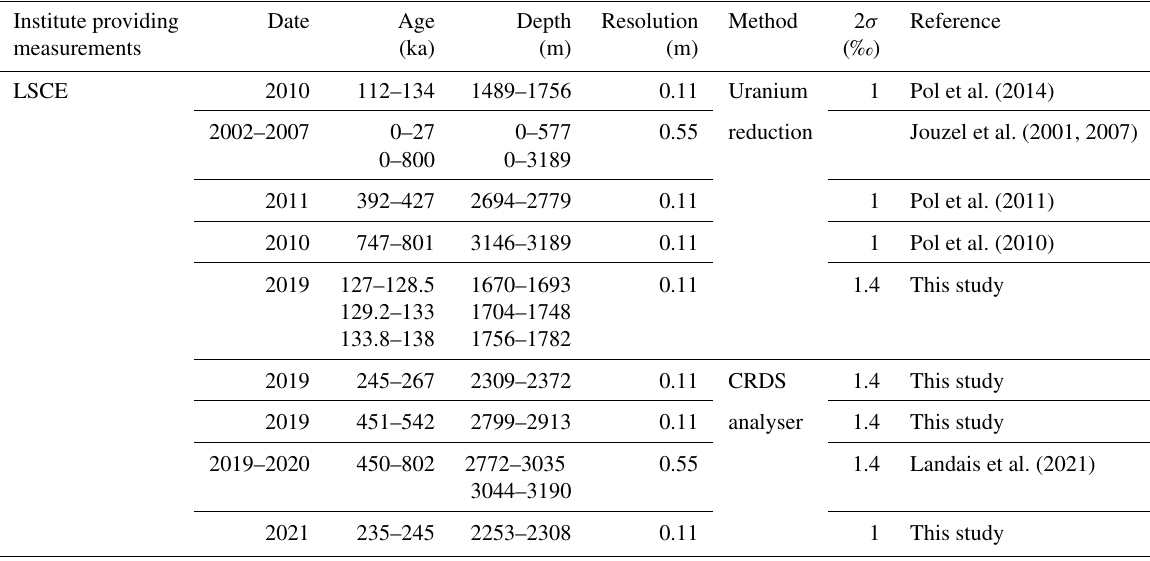
Table 1. Summary of available δ D measurements of the EDC ice core and associated analytical methods. 2 σ values come from the instru- mental measurement uncertainty as provided in the original studies.